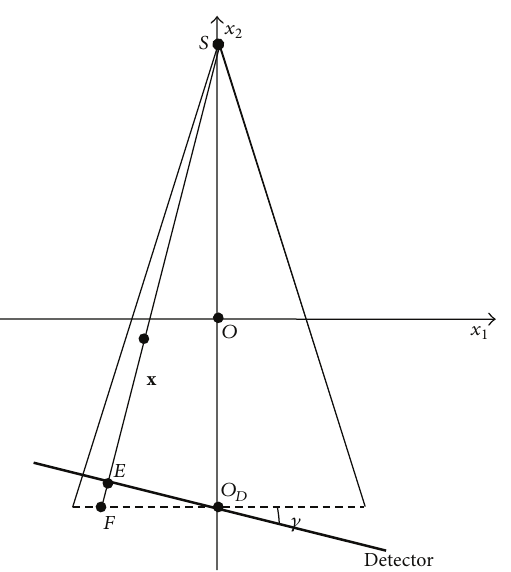
Figure 6: A simple geometric relationship of CT scanning system with the deflection of linear